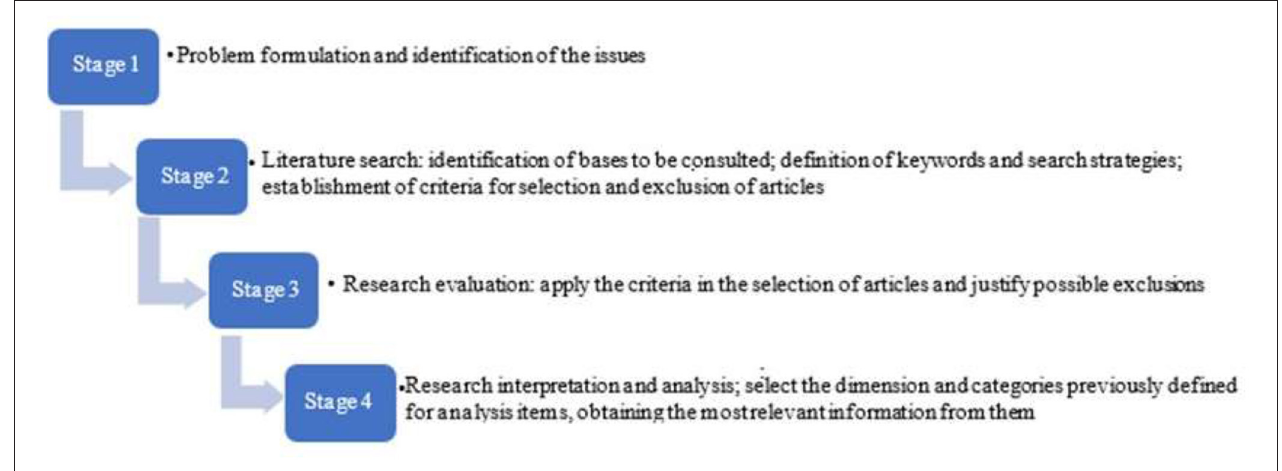
FIGURE 1 | Stages of the systematic review.